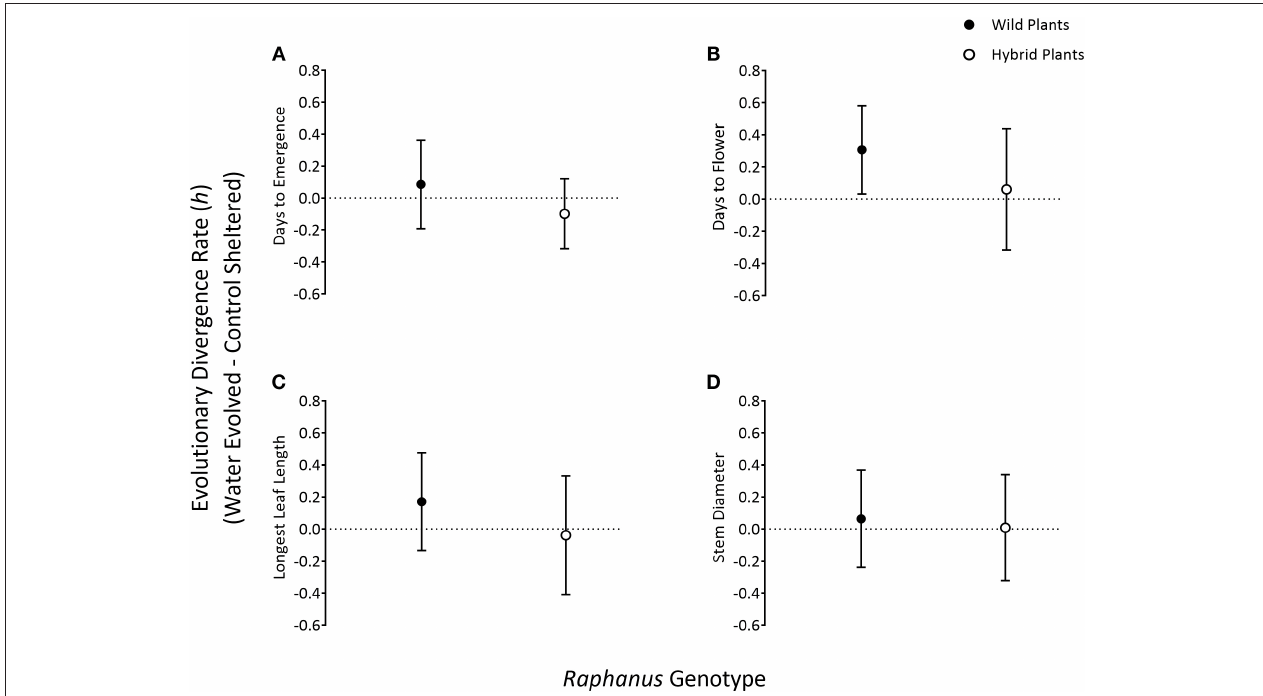
FIGURE 2 | Comparing evolutionary rate estimates [presented in haldanes ( h ) ± SD ] of four traits—days to seedling emergence (A) , days to flowering (B) , longest leaf length (C) , and stem diameter (D) —between G 5 radish weed genotypes (wild—closed circles, hybrid—open circles). Among wild populations, values represent the change between wild, water-evolved populations and wild, control-sheltered (CS) populations. Similarly, among hybrid populations, values represent the change between hybrid, water-evolved, and control-sheltered